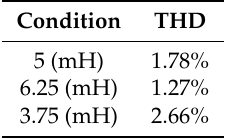
Table 3. THD of the currents for the suggested technique with variation of filter